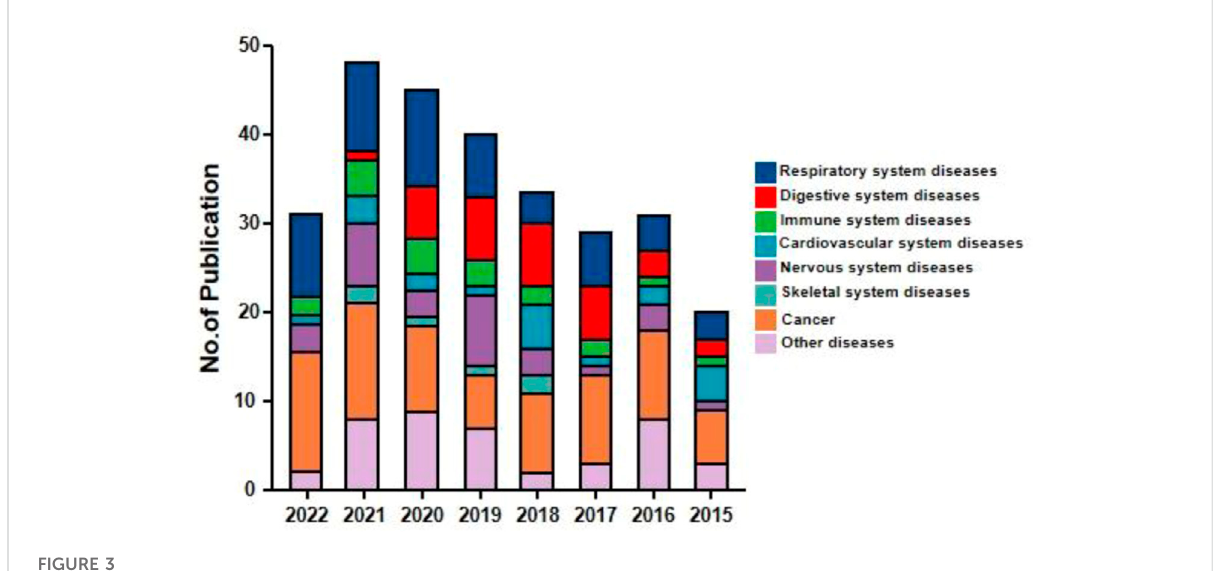
FIGURE 3 Number of publications on andrographolide (From 1 January 2015 to 1 August 2022)